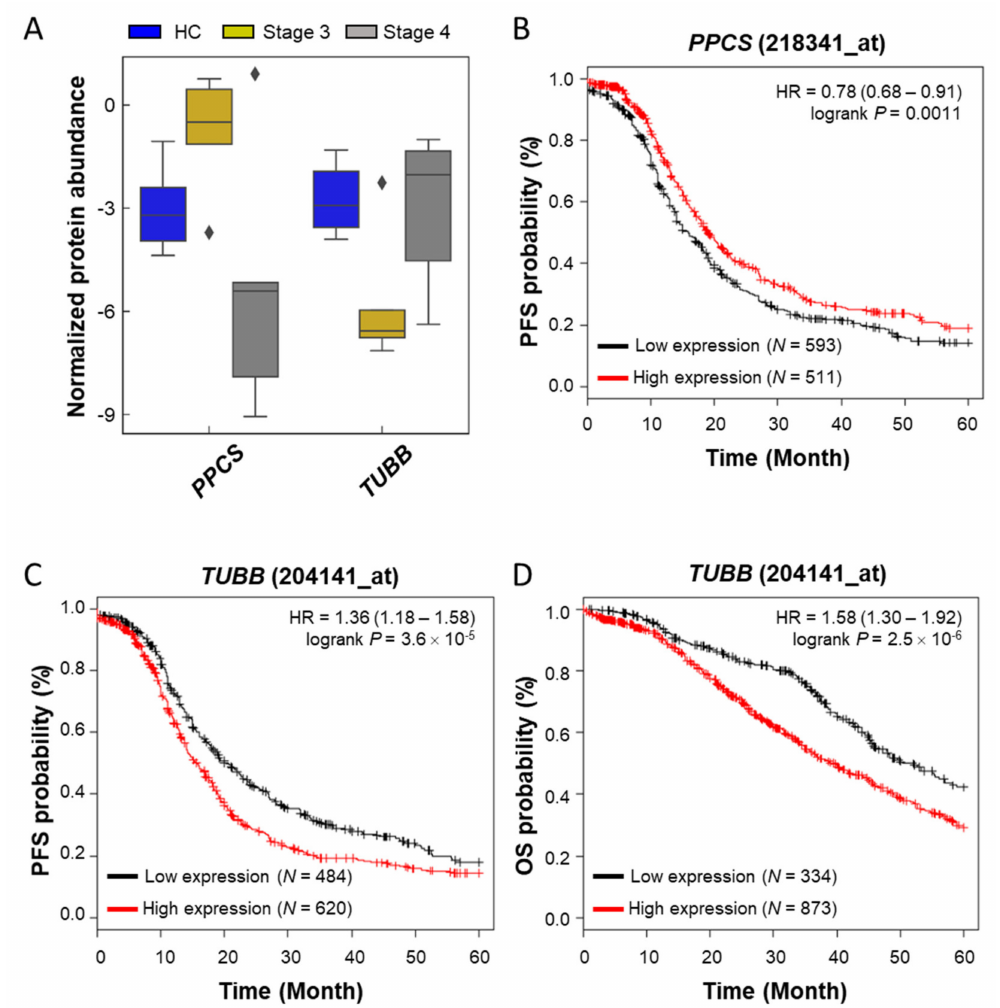
Figure 5. Boxplot and survival curves of two genes ( PPCS and TUBB ) selected as prognostic markers candidates. ( A ) A boxplot for the protein normalized abundances of two proteins in three groups obtained in this study; ( B ) Kaplan–Meier plot of PPCS (Probe set image ID: _at) in progression-free survival (PFS); ( C ) survival curve of TUBB (Probe set image ID: _at) in PFS; ( D ) survival curve of TUBB in overall survival